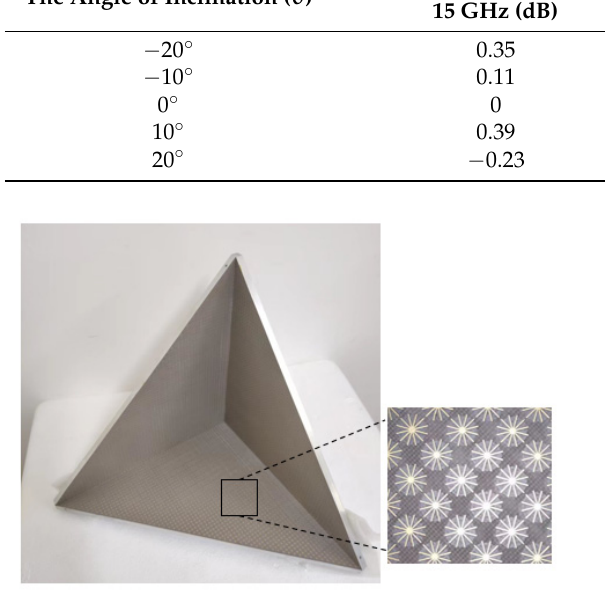
Figure 6. Machining TCR models.